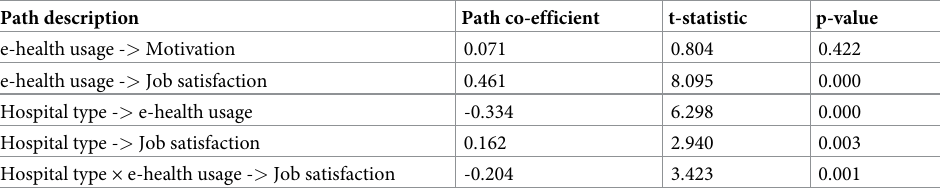
Table 3. Path coefficients of direct relationships and moderating effect of hospital